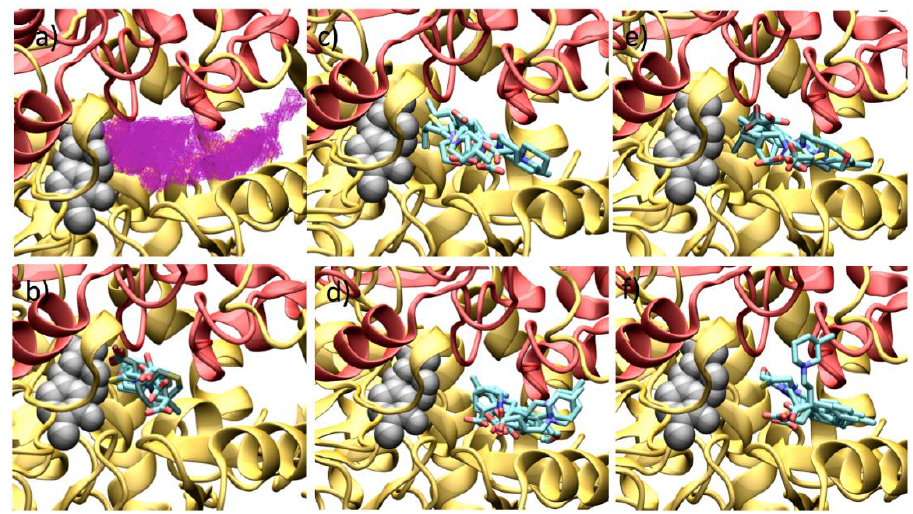
Figure 12. Docking results over human GABA-AT catalytic site. ( a ) Cavity form (magenta color mesh representation) of the GABA-AT catalytic site. ( b ) GABA analogues 7 . ( c ) ( S )-Pregabalin analogues 8 . ( d ) ( R )-Pregabalin analogues 8 . ( e ) ( S )-Baclofen analogues 9 . ( f ) ( R )-Baclofen analogues 9 . PLP prosthetic group is showed as gray Van der Waals spheres and each protein chain is colored in yellow and red. The compounds where the carboxylic moiety is oriented to PLP are colored in obscure.